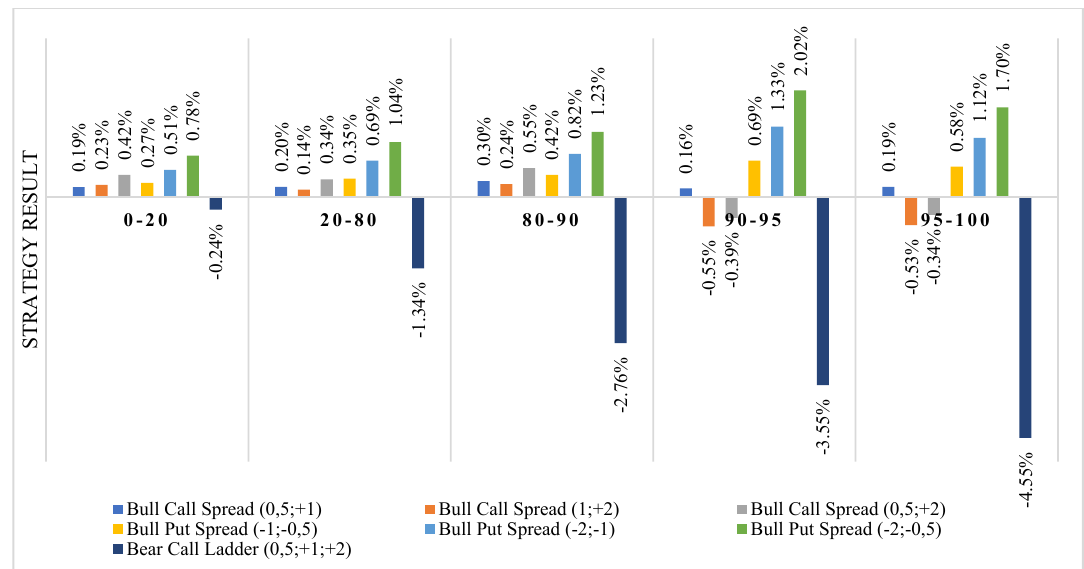
prices ranging from 5% to 10%.